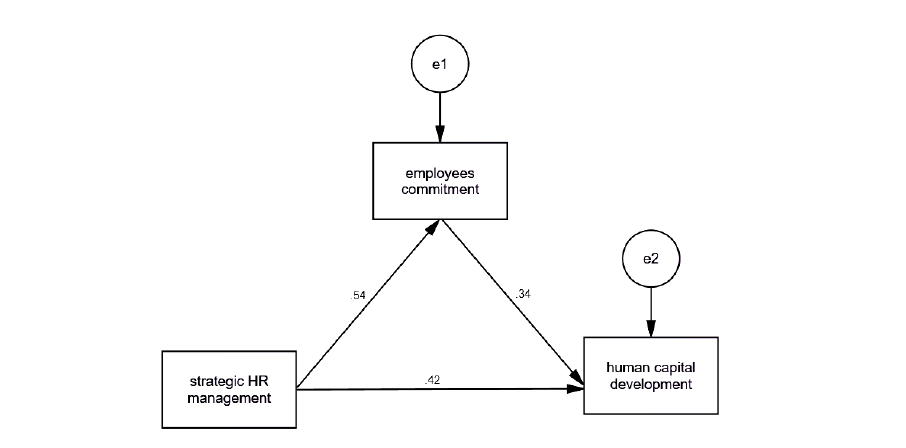
Figure 5. MF effect in the model